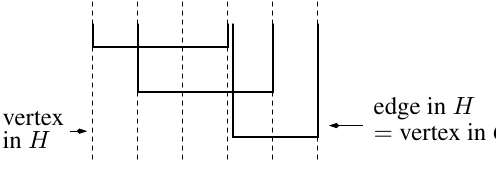
Fig. 6: 2-bend EPG representation of a line graph G with root graph H